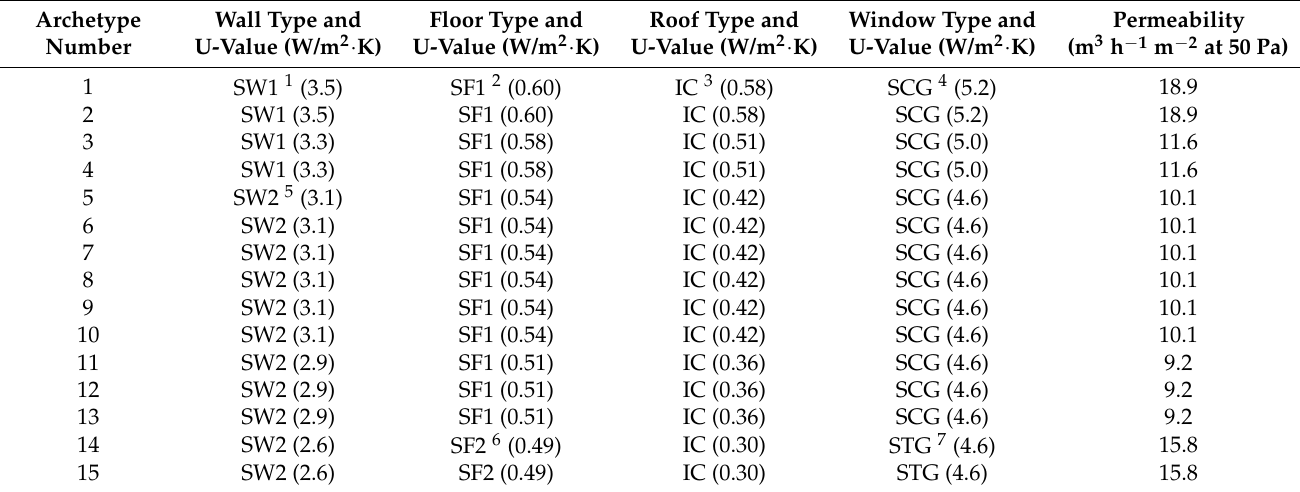
Table 3. A summary of the fabric characteristics for the modelled 15